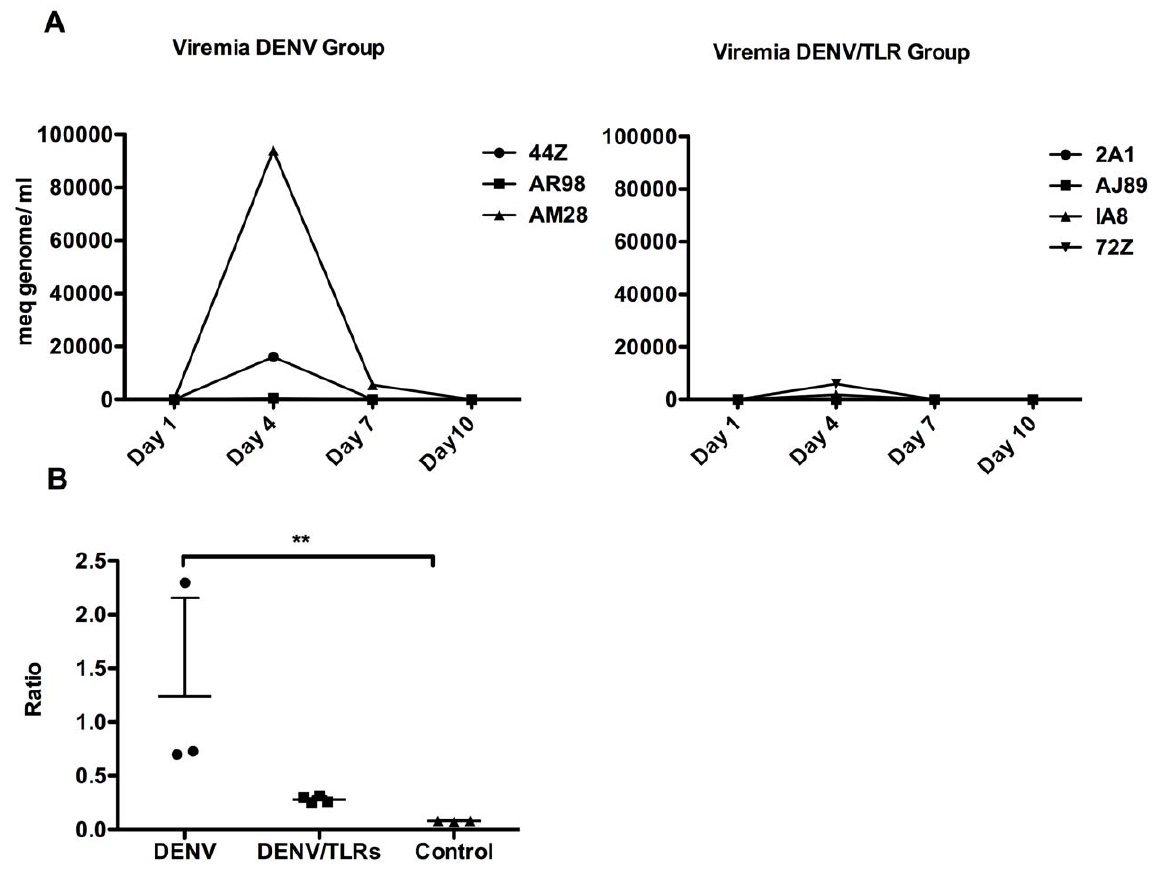
Figure 1. Toll-like receptor agonists abrogate viremia. A: Left panel, a peak of viremia was detected at day 4 after DENV infection in two of three animals (44Z and AM28). However, this peak was completely absent in the four animals of the DENV/TLR group at 48 hours after the TLR3 and 7/8 agonists [poly (I:C) and CL097M-012, respectively] were administered (right panel). Results are expressed in milliequivalent genomes per milliliter. B: Plasma levels of DENV protein NS1 were not significantly different between the DENV group and the treated group (DENV/TLR). However, NS1 levels were significantly higher in the DENV group compared to the Control group (p , 0.018), whereas they were not significantly different between the DENV/LTR (despite the Dengue infection) and the Control groups. This confirmatory assay corroborates the role of TLRs in controlling DENV replication. The results reflect the ratio of the sample O.D./Control O.D. according to the manufacturer’s instructions.